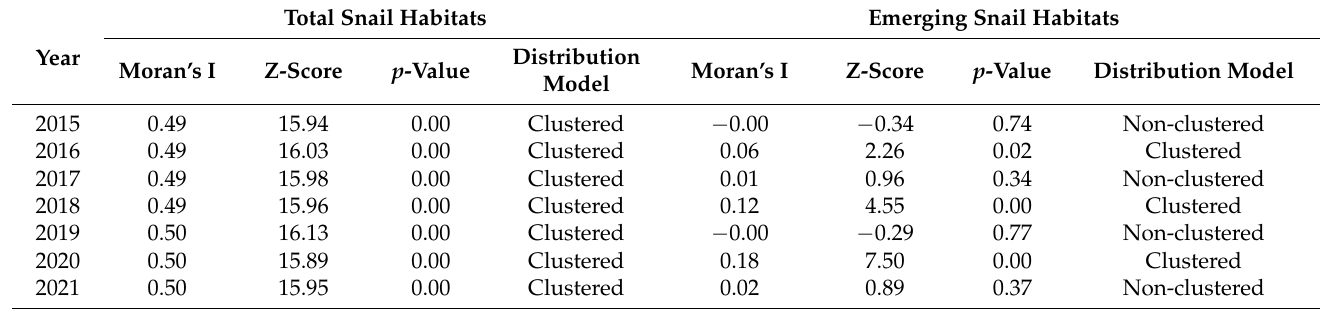
Table 1. Global spatial autocorrelation analysis of the distribution of the snail habitats in the endemic areas in the YEB from 2015 to